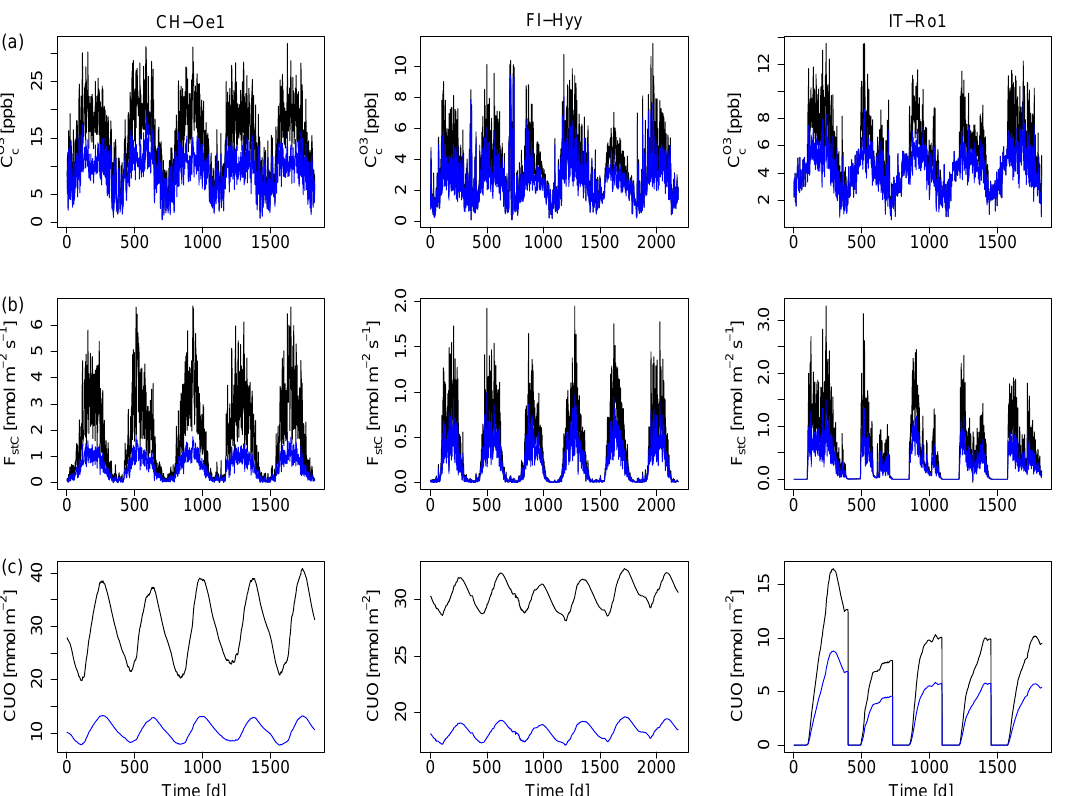
Figure A3. Differences in mean daily values of the (a) O 3 surface concentration (ppb), (b) canopy-integrated O 3 uptake into the leaves (nmolm − 2 s − 1 ), and (c) canopy-integrated cumulative uptake of O 3 (CUO) (mmolm − 2 ) for the three FLUXNET sites CH-Oe1, FI-Hyy and IT-Ro1. Blue: difference between the D-STO model and the standard model (D); black: difference between the ATM model and the standard model